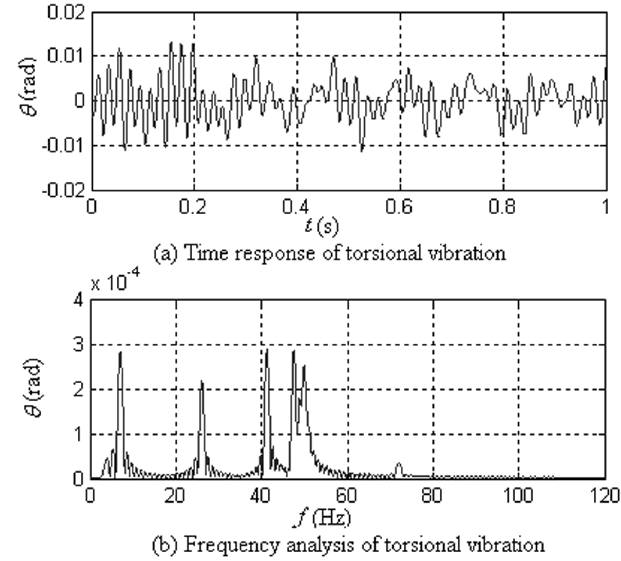
Fig. 10. Response and frequency analysis of the torsional vibration under 180 ◦ asynchronous